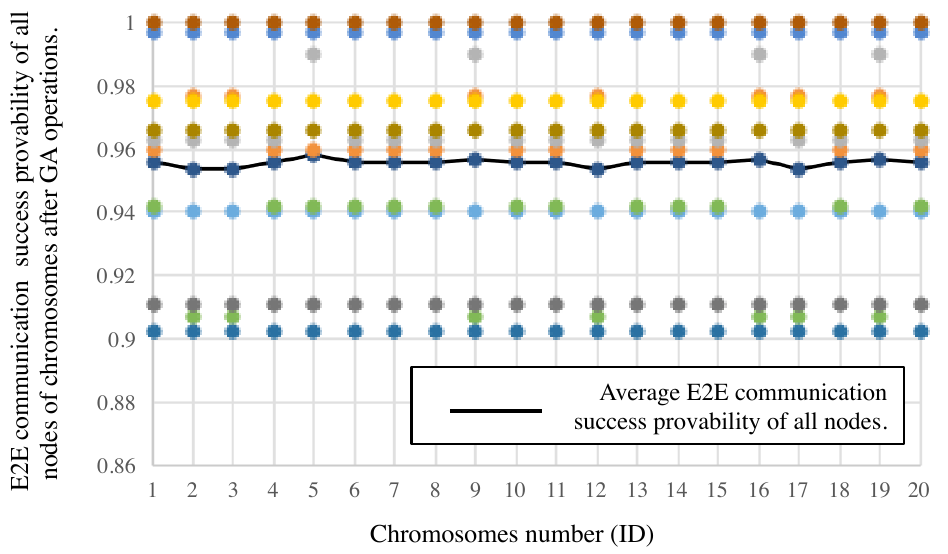
Figure 15. E2E communication "3"y of all nodes in the top 20 individuals and average one of all nodes in each individual, where N 1 = 8, N 2 = 1, and N 3 = 1.